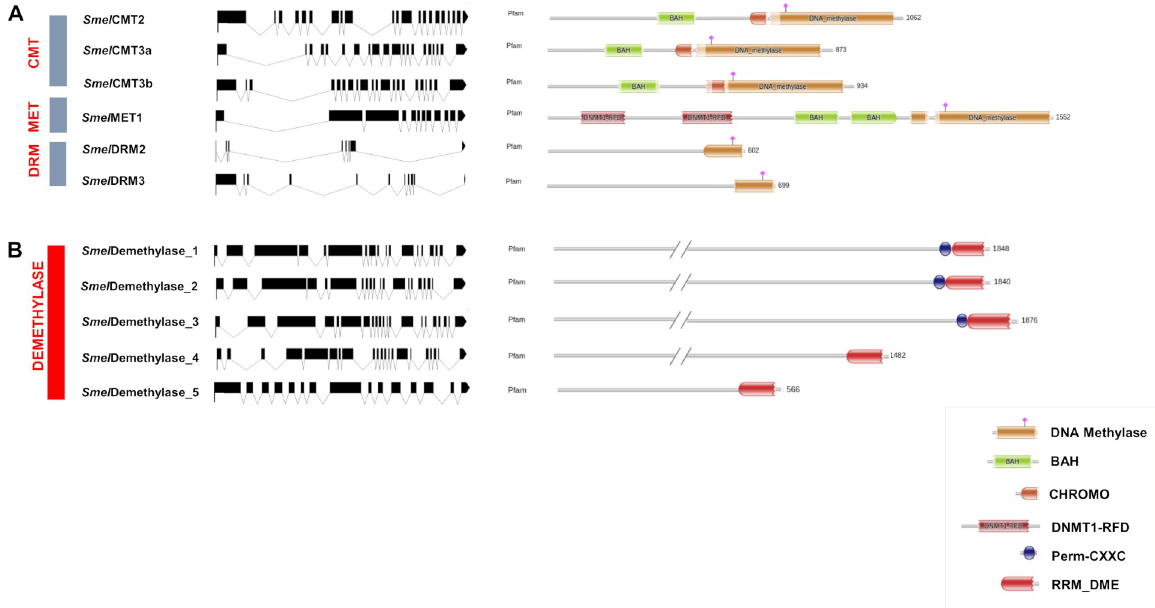
Fig 1. Gene and protein structure of the eggplant set of (A) C5-MTases, (B) demethylases. On the left hand panel the exon/intron structures are showed, with exons displayed as black boxes and introns as lines (generated using the tool provided at http://wormweb.org/exonintron). Name of the motifs/domains are shown inside the figure. Acronym explanations: BAH = Bromo Adjacent Homology domain; CHROMO = CHRromatin Organisation MOdifier domain; DNMT1-RFD = Cytosine specific DNA methyltransferase Replication Foci Domain; Perm-CXXC = Permuted single zf-CXXC unit; RRM_DME = RNA-recognition motif in Demeter.